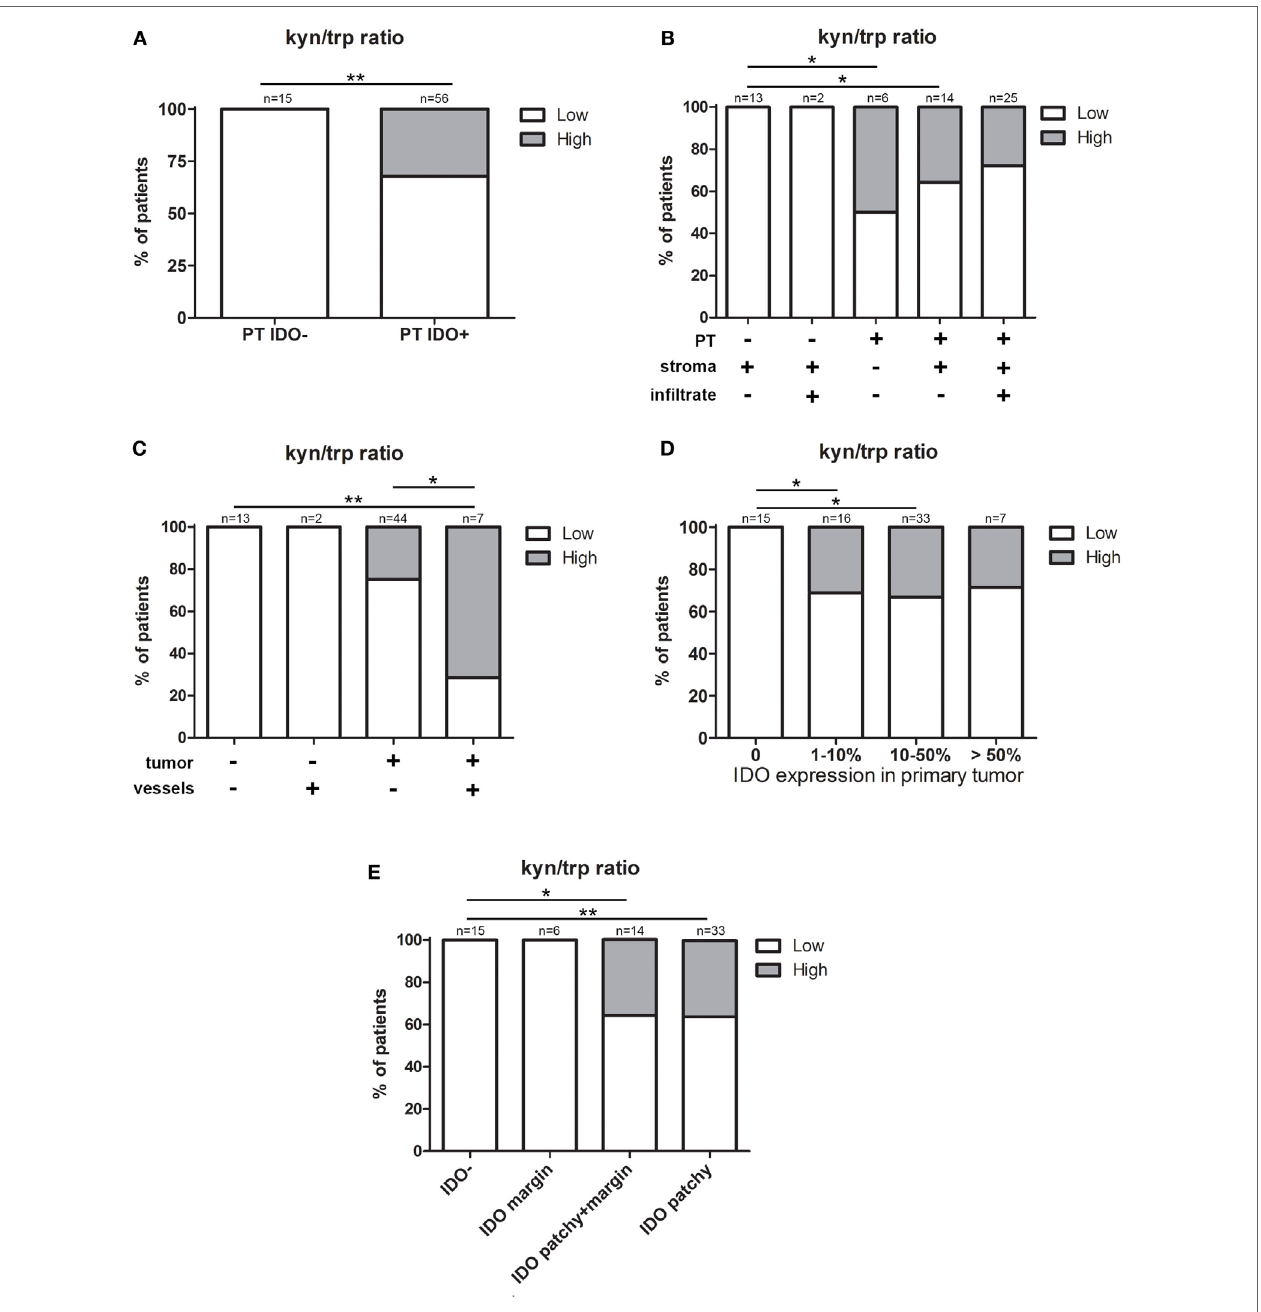
FigUre 3 | The influence of indoleamine 2,3-dioxygenase (IDO) expression in the local tumor microenvironment on the kyn/trp ratio in serum. Graphs show low (16.78–34.91, white) and high (34.92–52.37, gray) serum kynurenine/tryptophan (kyn/trp) ratio for (a) patients with IDO expression (IDO − /IDO + ) in primary tumor (PT). Further stratification for expression patterns in (b) stroma and infiltrating immune cells (stroma and infiltrate) and (c) tumor-associated vessels (vessels). (D) Patients with IDO-negative tumors (0%) and patients with IDO-positive tumors divided into groups of 1–10, 10–50, and more than 50% of IDO positivity in tumor cells, and for (e) patient groups with different IDO expression patterns including IDO-negative (IDO − ), IDO margin, IDO patchy + margin, and patchy IDO expression by PTs. P values were calculated excluding subgroups with n = 2 or smaller, using (pairwise) Fisher’s exact test. * P = 0.01–0.05 and ** P =